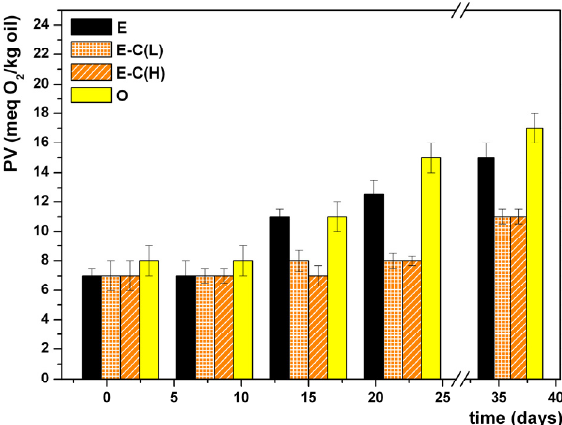
Figure 2. PV as a function of time in: E, w/o emulsion; E-C(L) w/o emulsion enriched with low concentration of vitamin C; E-C(H) w/o emulsion enriched with high concentration of vitamin C; O, oil (bars represent standard deviation of mean values).